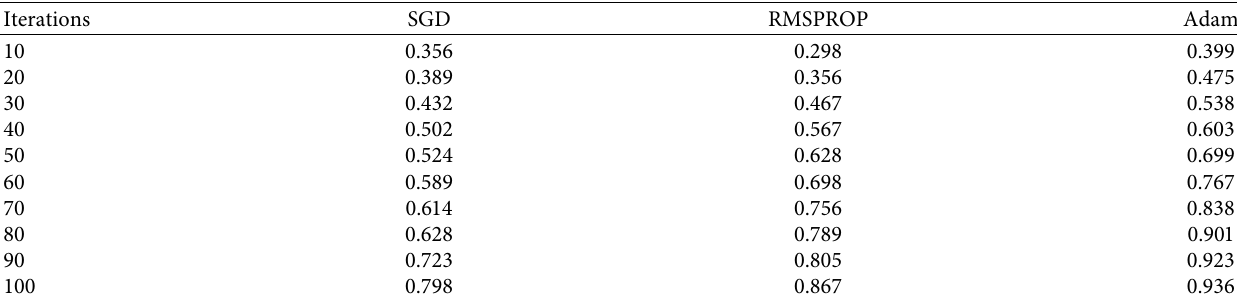
Table 1: The relationship between optimizer and recognition rate in HMDB51 dataset.